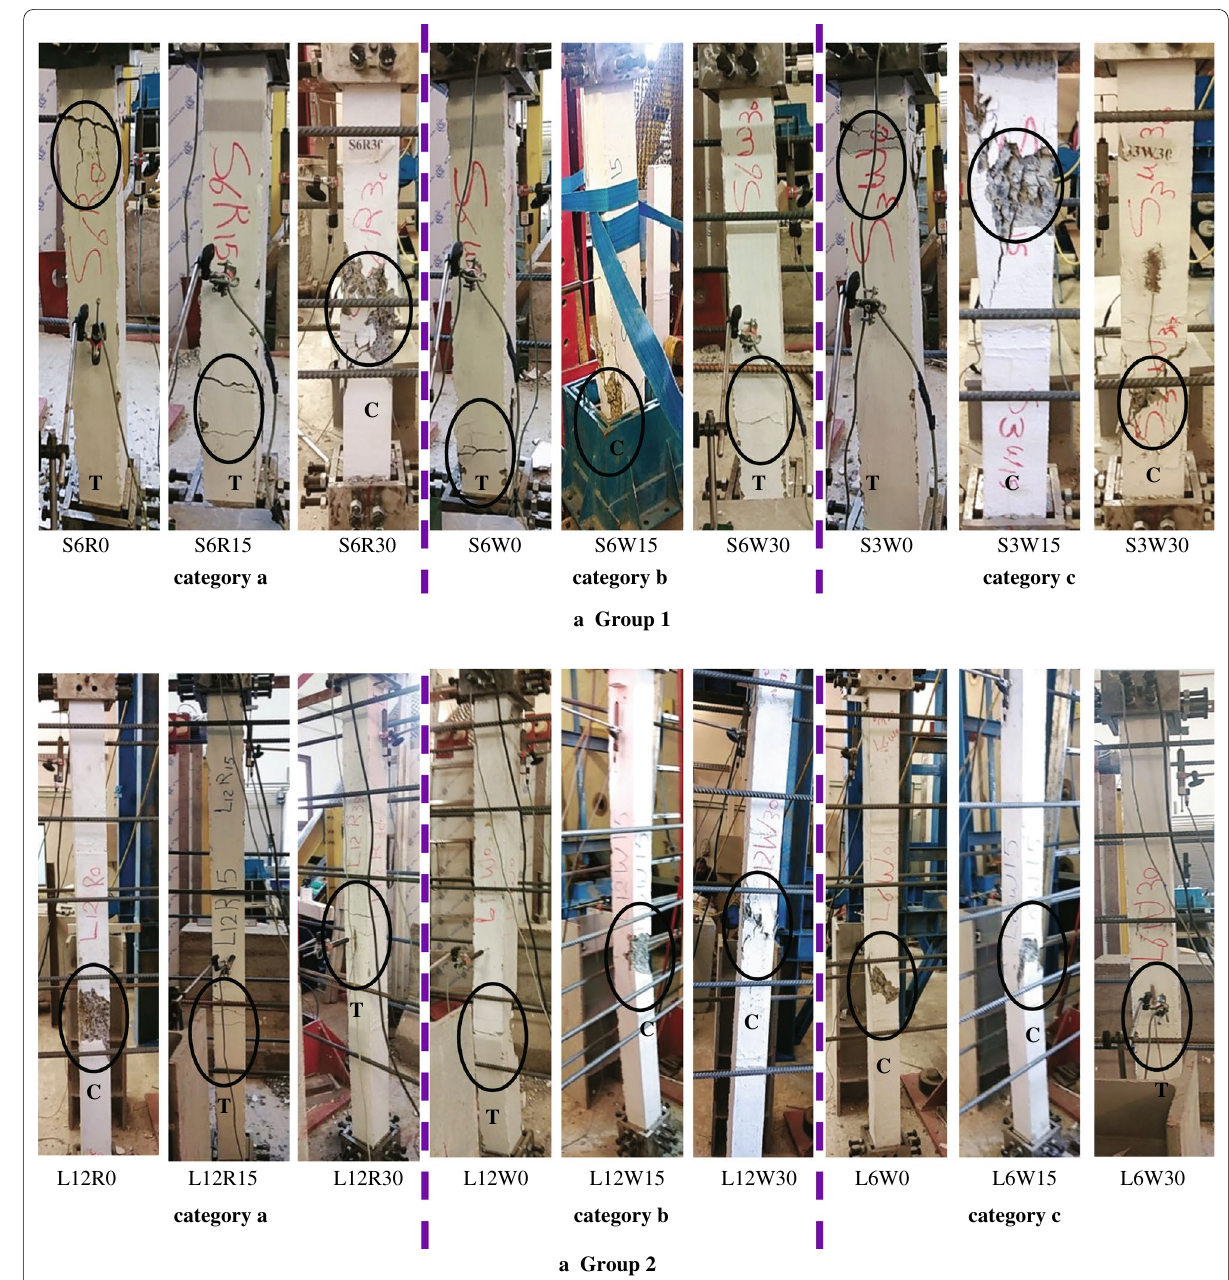
Fig. 16 Failure of tested